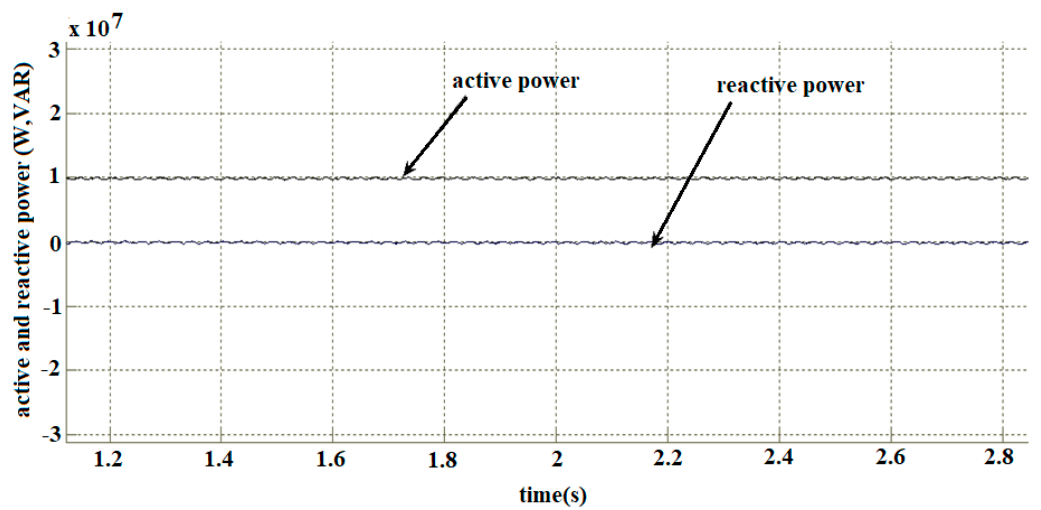
Figure 12. Hexverter’s output voltage and current waveforms.